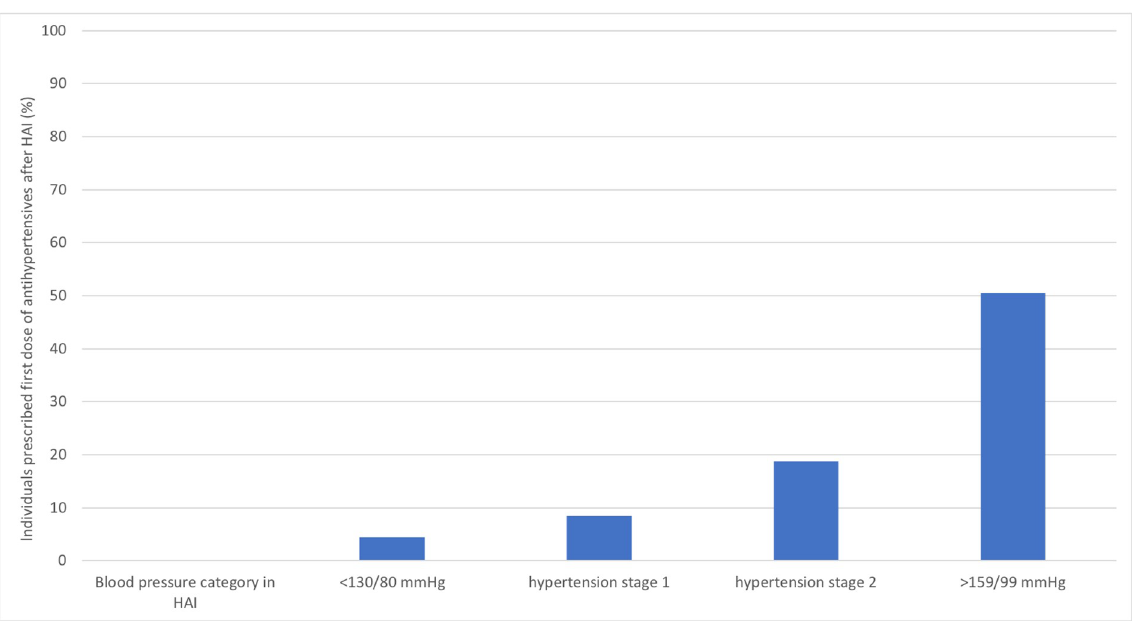
Fig 4. Initiation of blood pressure treatment in treatment-na ï ve Healthy Ageing Initiative (HAI) participants based on blood pressure category at baseline ( n = 1,541). Hypertension stage 1: systolic blood pressure of 130–139 mm Hg or diastolic blood pressure of 80–89 mm Hg. Hypertension stage 2: systolic blood pressure of � 140 mm Hg or diastolic blood pressure of � 90 mm Hg.